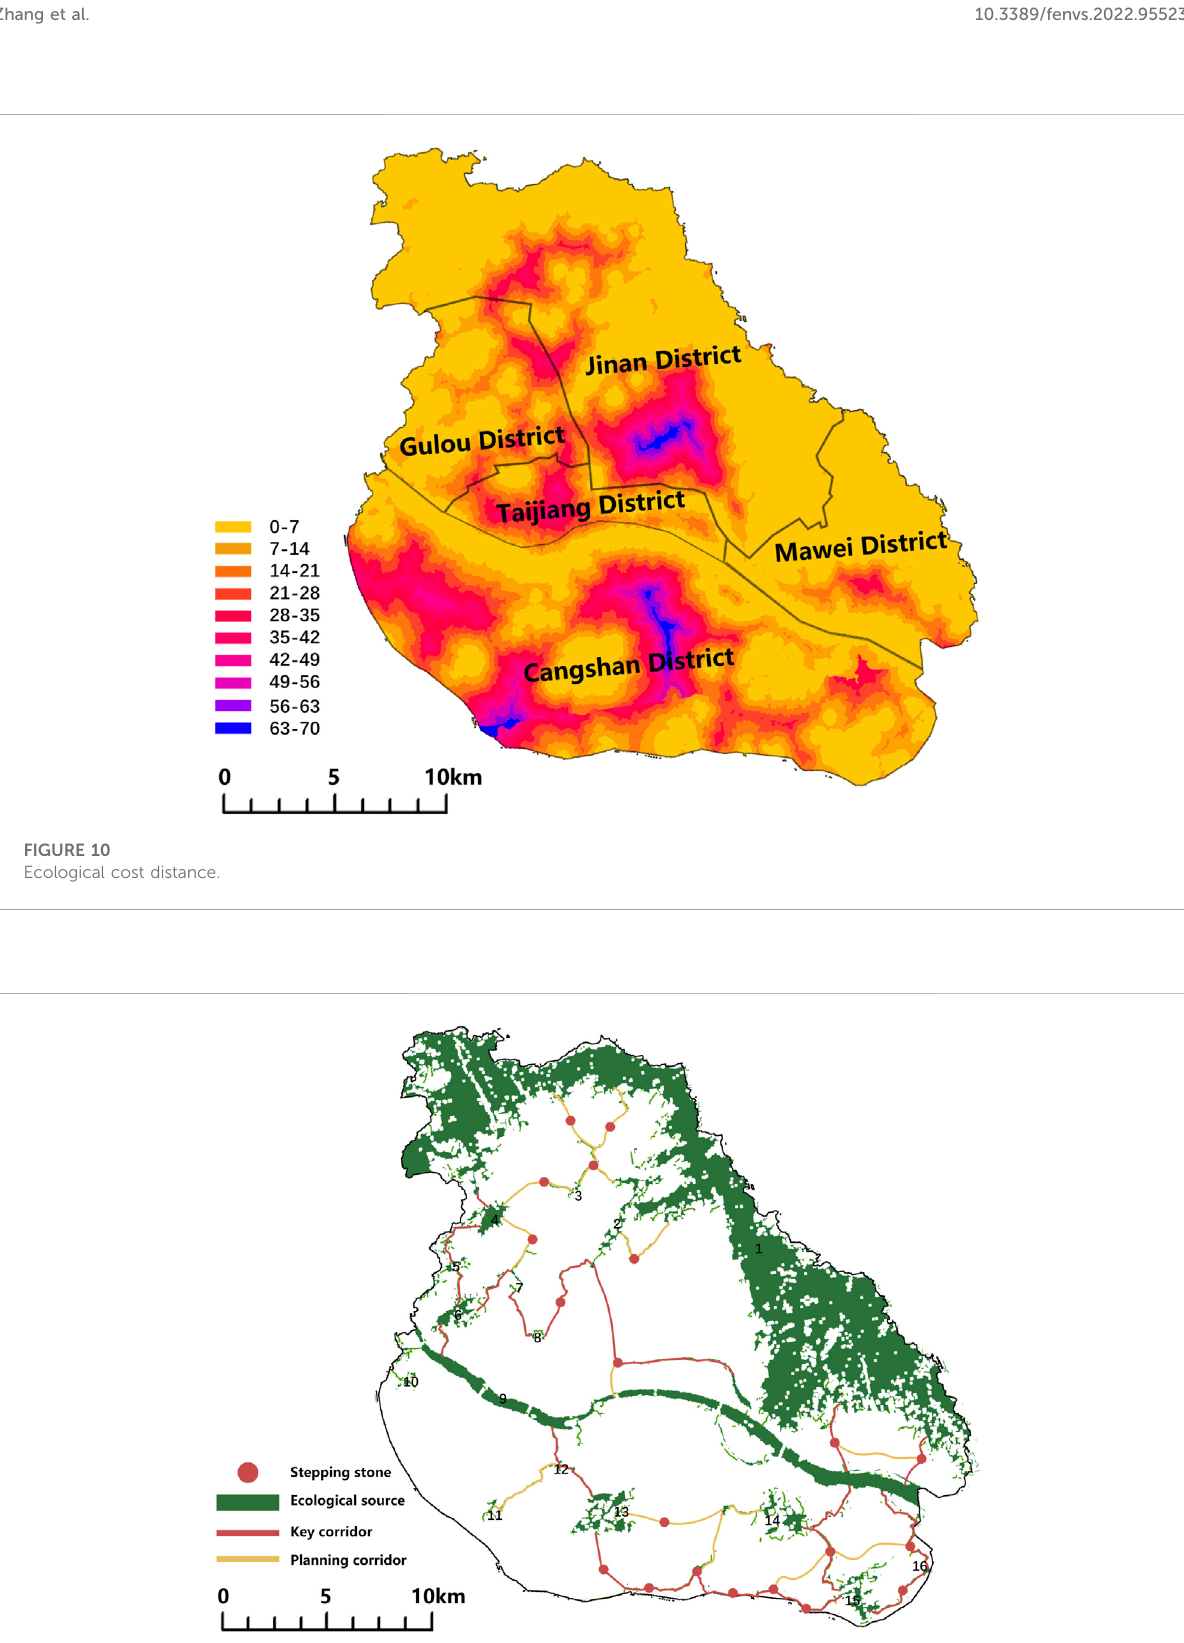
FIGURE 11 Ecological corridor importance and